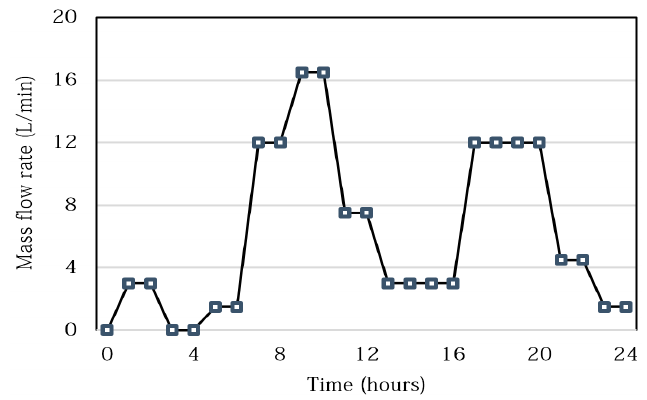
Figure 13. The supply pattern of daily DHW. Table 2. The parameters of Geo-PVT system in rated condition.